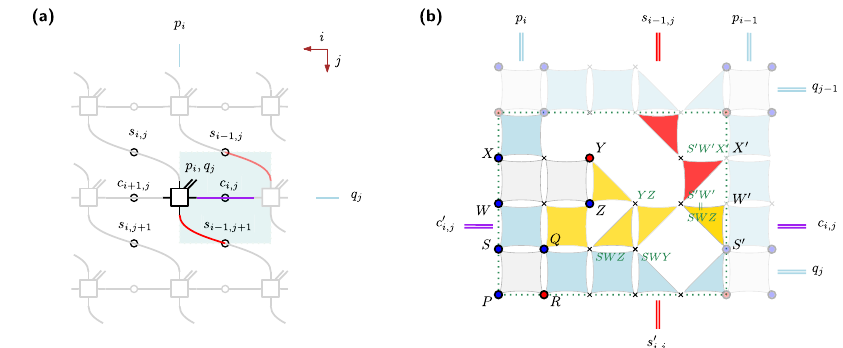
Fig. 5 Blueprint for parity factorization - Planar layout. a Multiplication circuit as an array of CFA cells. Cells are enumerated by their inputs, p i and q j . b Parity-based planar CFA unit cell. Compared to the 3D implementation, the unused space between primary plaquettes ( PQRS ) ij is enlarged to embed the second primary plaquette ( WXYZ ) ij . Additional plaquettes transmit and process incoming and outgoing carry/sum variables. The multiplication circuit is then constructed by tiling the plane with unit cells, treating border cases differently, as shown in Supplementary